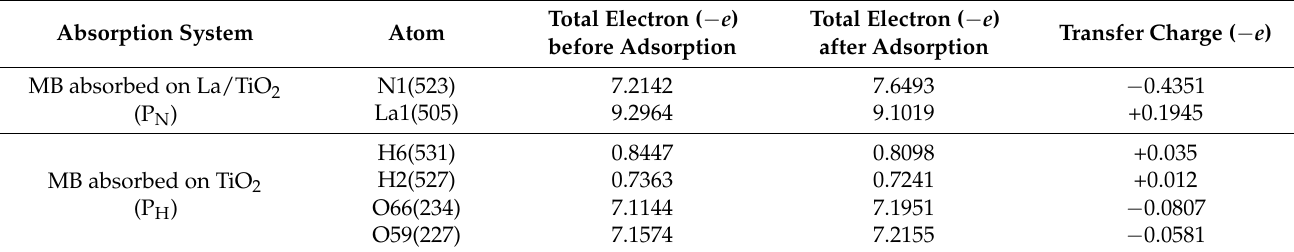
Table 3. Bader’s charge analysis for the selected atoms at the